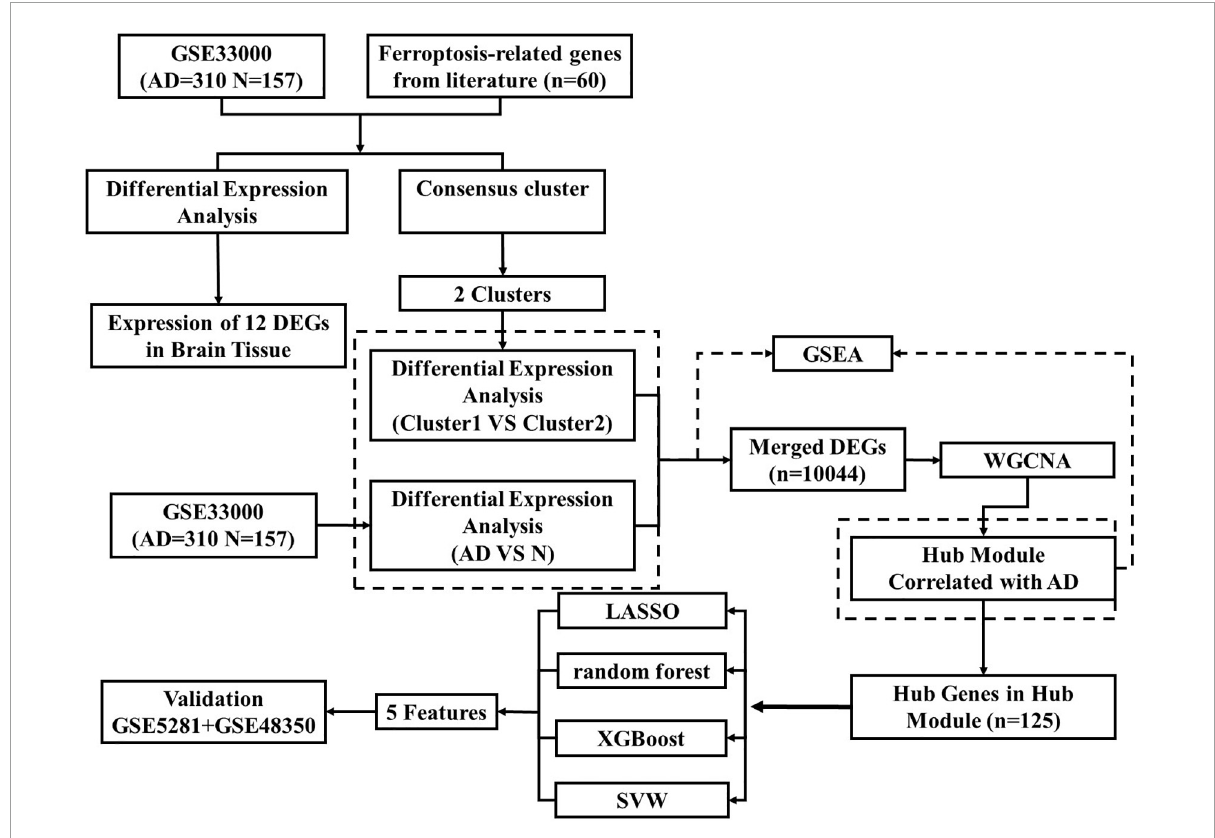
FIGURE1 The overview of the whole study.